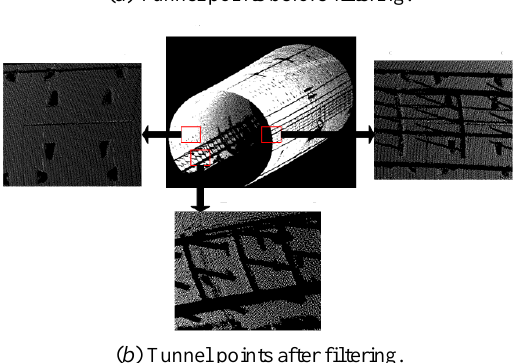
( a ) Tunnel points before filtering.